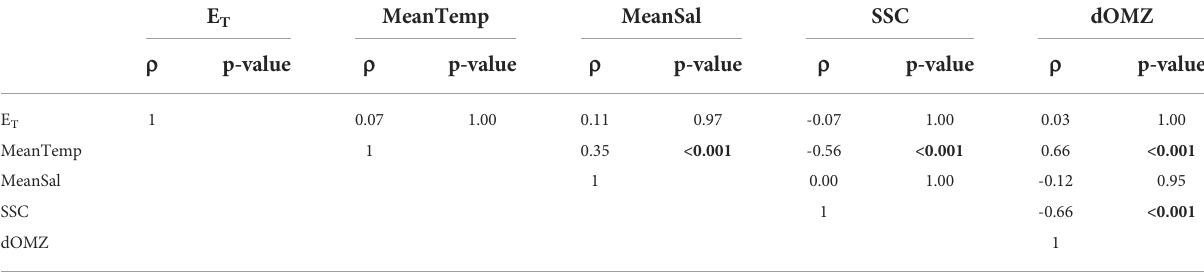
TABLE 1 Spearman correlations among the environmental variables selected as covariates for the HGAM